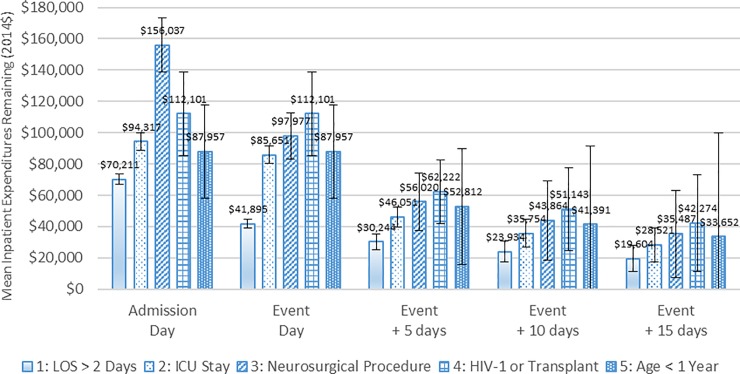
Mean inpatient healthcare expenditures remaining after the subgroup-defining event day for patients with encephalitis, 2010 to 2014.Notes: The first 90 days and the last 90 days are excluded from the 2010 to 2014 period. For patients in Subgroup 4 (HIV-1 or Transplant) and Subgroup 5 (Age < 1 year), the subgroup-defining event day is the same as the initial hospital admission day because these patients could be classified into these subgroups upon admission. The values reported in the figure are the estimated means, and the error bars indicate the 95% confidence intervals of those estimates. Source: Authors’ analysis of 2010 to 2014 Truven Health MarketScan Commercial Claims and Encounters Database.